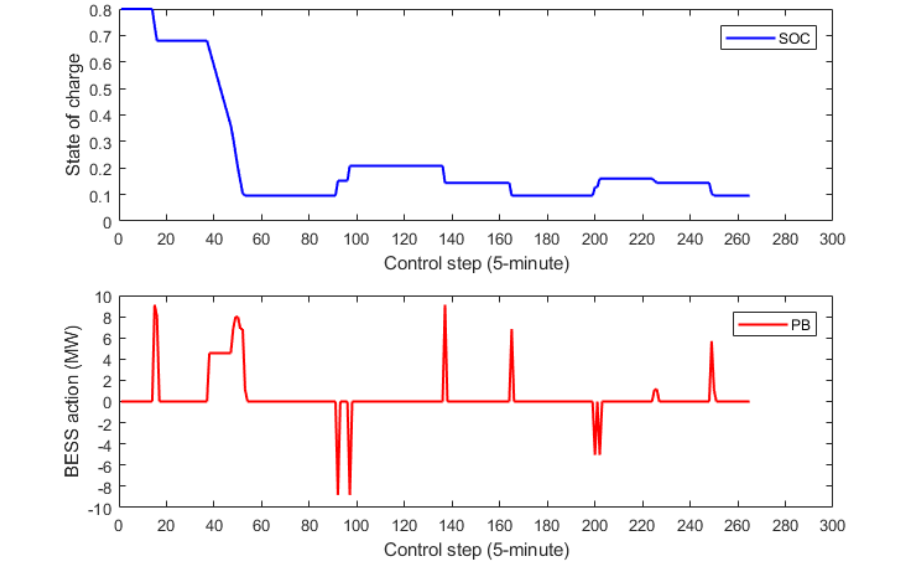
Figure 9. BESS actions and SOC (lower